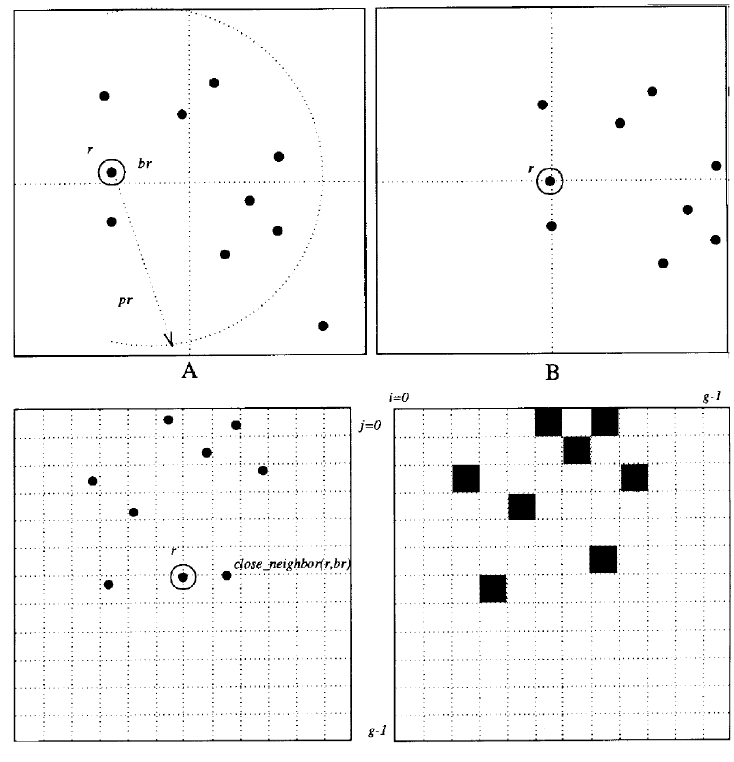
Figure 6. Illustration of Padgett’s Grid Algorithm (reprinted from